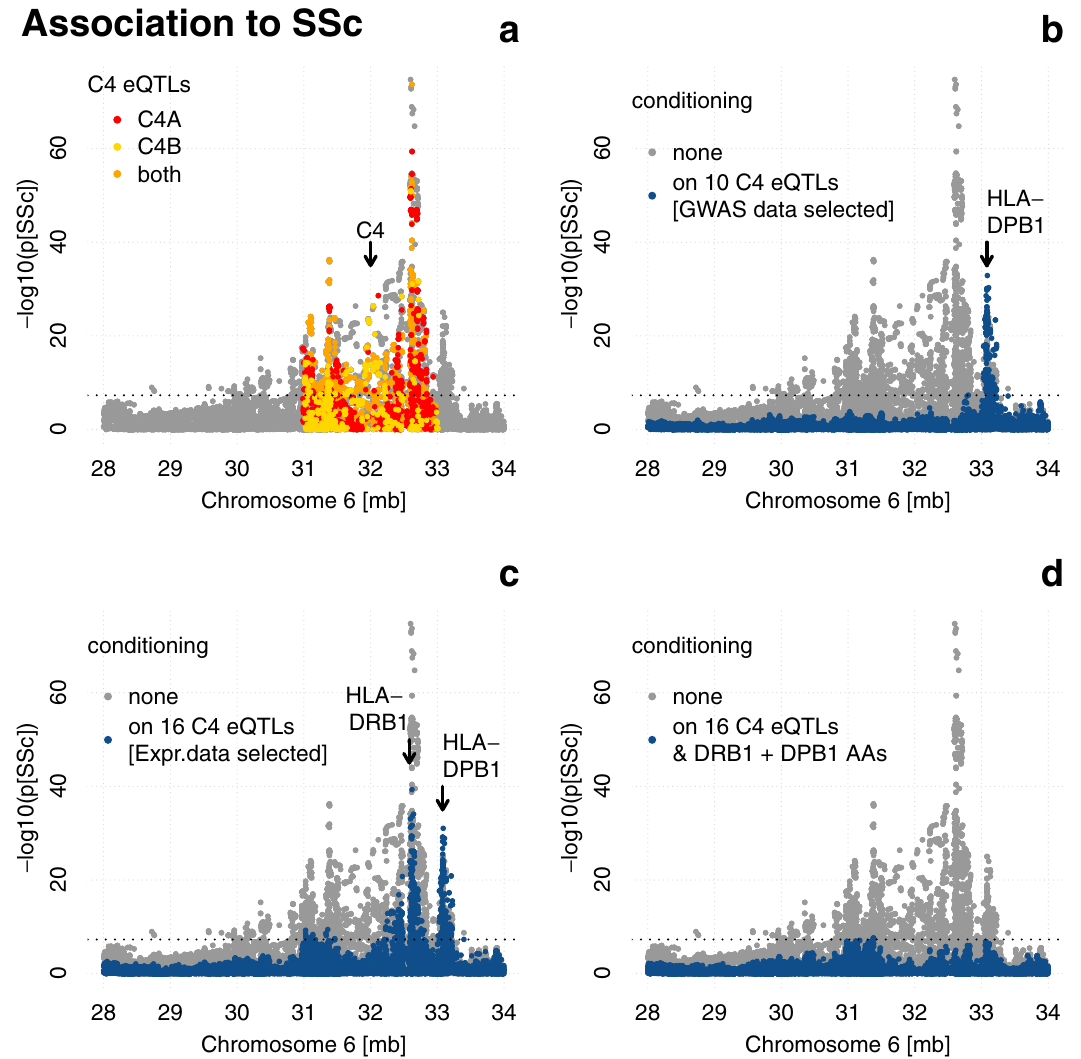
Fig. 3 MHC region conditional association with systemic sclerosis. Association is calculated in the fi rst dataset ( N = 26,633) using logistic regression with cohort, genetic background (PC1-5), and sex as covariates and depicted as position (GRCh38) by signi fi cance (Manhattan plot) in gray if no additional covariates were used. The dotted line represents the genome-wide signi fi cance cutoff P = 5 × 10 − 8 . a Manhattan plot with marked C4 eQTLs obtained from the GTEx v8 database. b Manhattan plot with additional conditioning on ten independent C4 eQTLs, obtained by forward selection in the fi rst dataset, depicted in blue. The arrow marks the position of HLA-DPB1 . c Manhattan plot with additional conditioning on 16 independent C4 eQTLs (obtained by forward selection to explain expression variance in the second dataset ( N = 857) depicted in blue. The arrows mark the positions of HLA-DPB1 and HLA-DRB1 . d Manhattan plot with additional conditioning on 16 independent C4 eQTLs (obtained by forward selection to explain expression variance in the second dataset) and 8 independent amino acids of DRB1 and DPB1 (obtained by forward selection in the fi rst dataset conditioning on 16 independent C4 eQTLs) depicted in